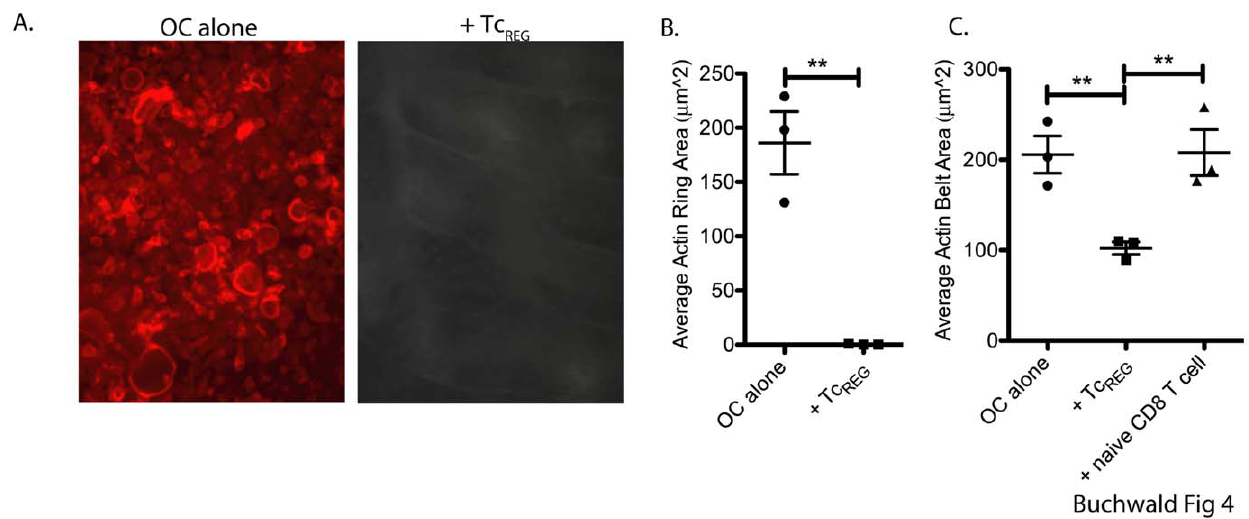
Figure 4. Tc REG suppress mature osteoclasts by effecting the cytoskeletal reorganization: Osteoclasts were cultured either alone or with Tc REG on bovine bone chips for 24 hrs. T-cells were then removed, and osteoclasts were stained with phalloidin-Texas Red to visualize actin rings. Representative images are shown in panel A . Quantitation of three independent experiments is shown in panel B . Panel C is quantitation of phalloidin staining of osteoclasts plated on tissue culture treated dishes. Statistical significance of actin ring area was assessed by non-parametric paired T test: **: P , 0.01 in comparison to osteoclast alone.